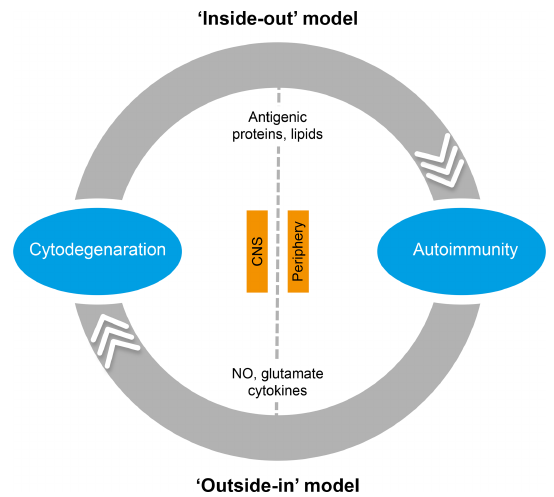
Figure 5. Two opposing paradigms explaining the cause of autoim- munity in MS. The prevailing concept is the outside-in paradigm, namely that infection of individuals who are genetically predis- posed to MS with an as yet unidentified microorganism activates autoreactive T and B cells present in the normal immune reper- toire. The autoimmune attack on the CNS induces cytodegenera- tion. Less commonly accepted is the inside-out paradigm, which states that a pathogenic event inside the CNS elicits the release of myelin antigens that activate autoreactive T and B cells present in the normal immune repertoire. The principle difference between both paradigms is that in the outside-in paradigm infection is the direct trigger of autoimmunity, whereas in the inside-out paradigm infections create a higher responsive state of the immune